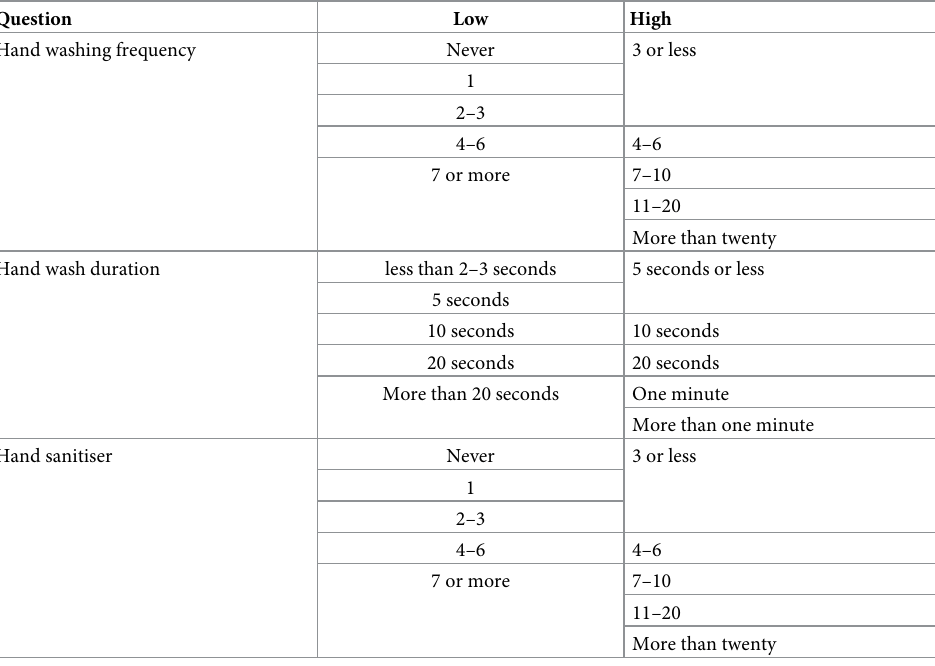
Table 4. Respondents were then asked seven attitude questions shown below. Respondents used a 0–100 sliding scale. Responses were measured to the tenth, for example 29.4. Our analyses con- cerning these variables are exploratory and concern whether the set of response alternatives that were presented affects the responses on these variables. Being in the low condition may make respondents think they perform those behaviors more than most, and being in the high condition may make respondents thing they perform those behaviors less than most. The first two items below explore if this also impacts the relative concerns people express toward Table 4. The response alternatives for the low and the high frequency conditions. The dashed lines show how the raw data can be re-coded for comparable frequencies/durations. Question Low High